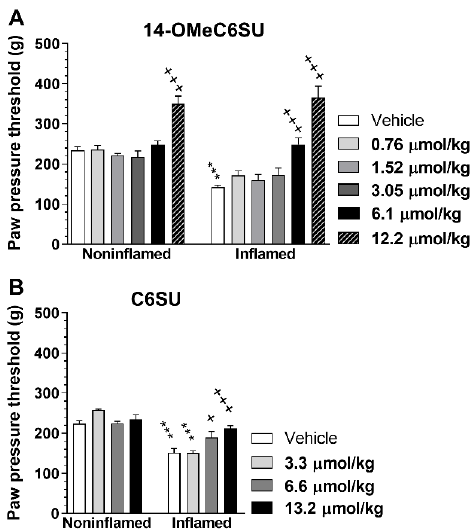
Figure 6. The peak antinociceptive effects of subcutaneously administered 14-OMeC6SU ( A ) and C6SU ( B ) in Complete Freund’s Adjuvant (CFA)-induced inflammatory pain. Figures indicate the paw pressure threshold in g-s in the presence of 14-OMeC6SU or C6SU in the indicated dosages 30 min after the injection of the tests compounds. Data represent means ± S.E.M. (n = 5–11 per group). * significant difference between inflamed and noninflamed paw within the corresponding treated group (two-way ANOVA, Sidak’s multiple comparisons test). + significant difference compared to inflamed paw of vehicle treated group or compared to vehicle and 14-OMeC6SU 6.1 µmol/kg in the noninflamed (two-way ANOVA, Tukey’s multiple comparisons test). *** /+++ P < 0.001; + P < 0.05.